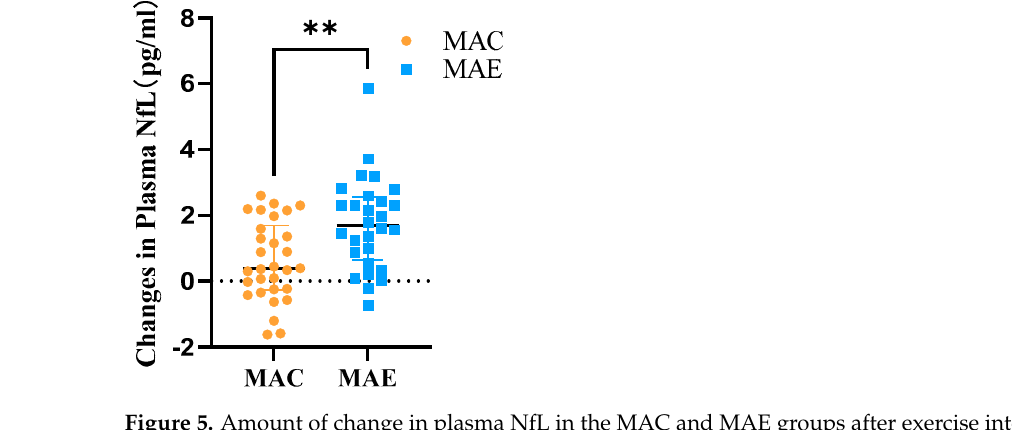
Figure 5. Amount of change in plasma NfL in the MAC and MAE groups after exercise intervention. **: There was a significant difference in the amount of change in Plasma NfL before and after the exercise intervention in the MAE group compared to the MAC group.